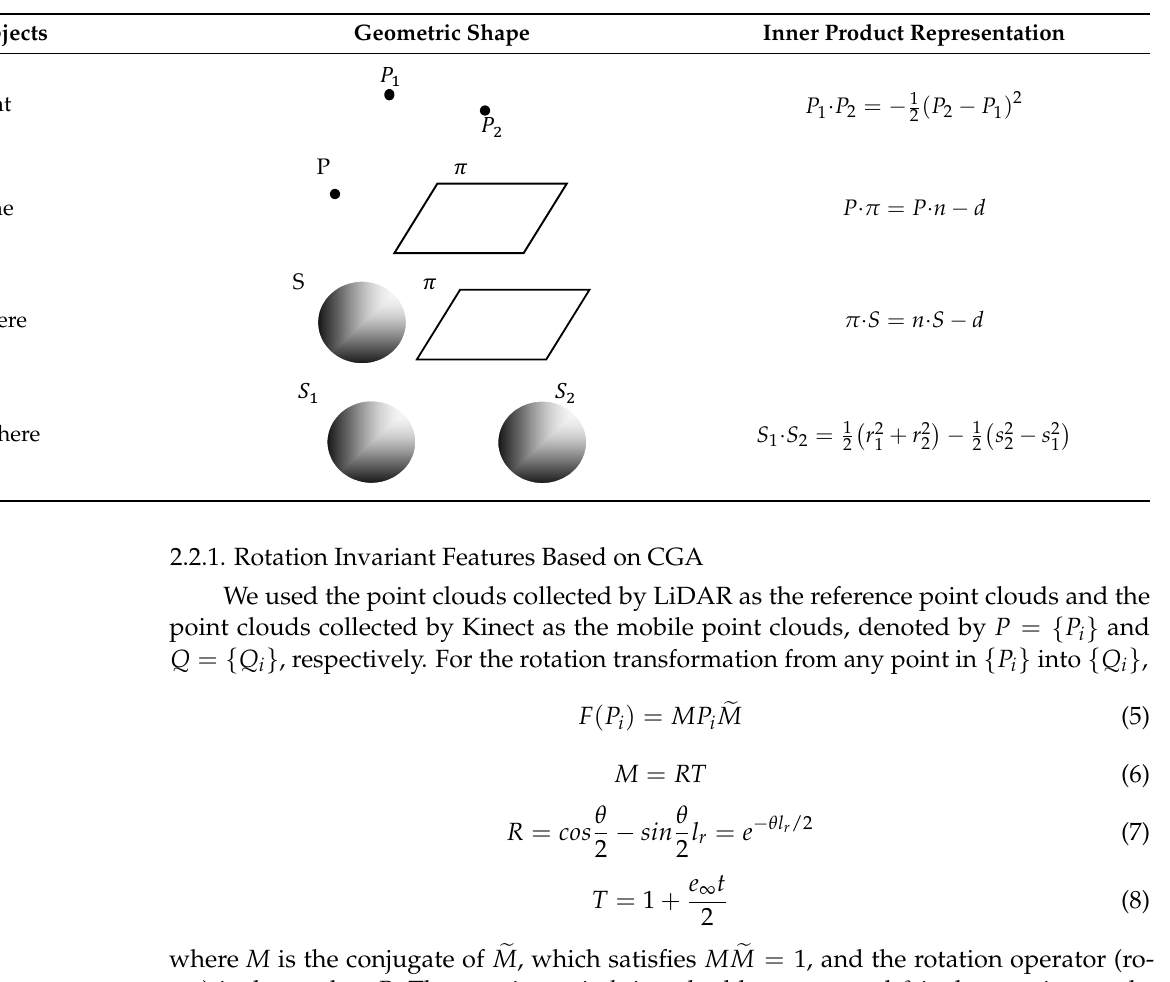
Table 1. Expression of the inner product of different geometric objects in CGA [42].